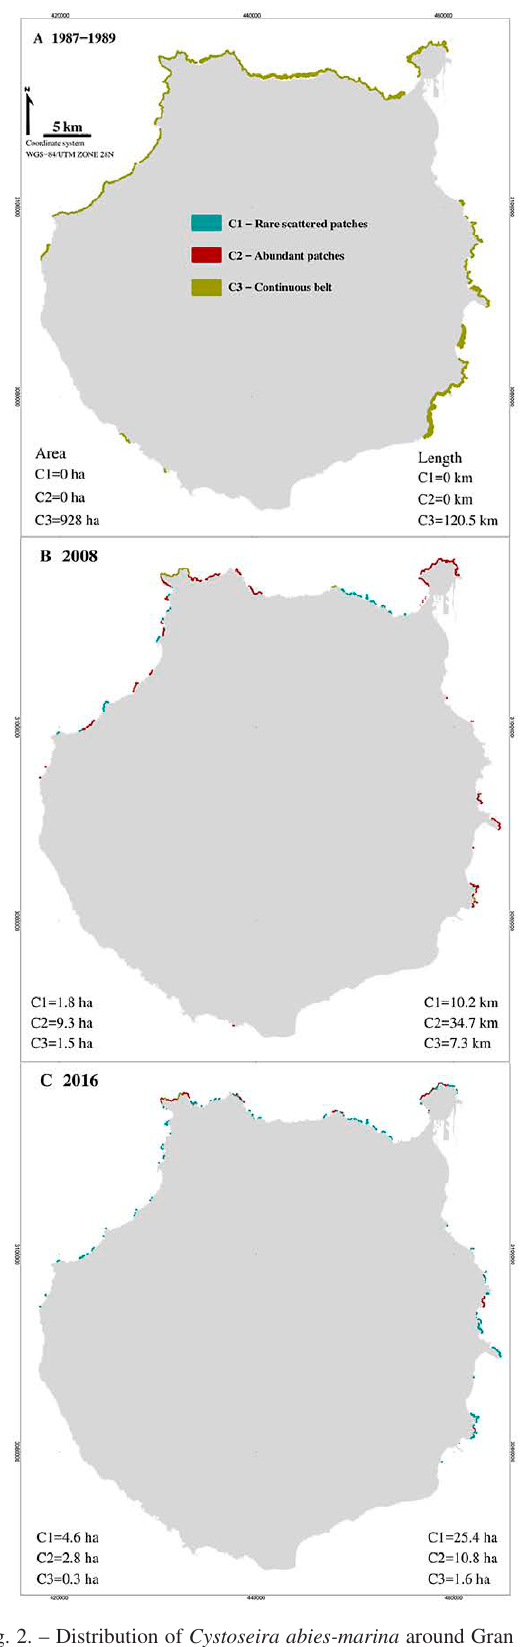
Fig. 2. – Distribution of Cystoseira abies-marina around Gran Ca- naria Island in the 1980s (A), 2008 (B) and 2016 (C). The area (ha) and length (km) of the three types of stands is included (C1, scat- tered patches; C2, abundant patches; C3, continuous